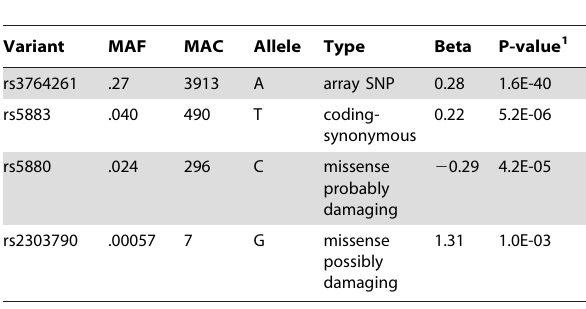
Table 4. Rare and common variants contribute to the association signal to HDL-C in gene CETP